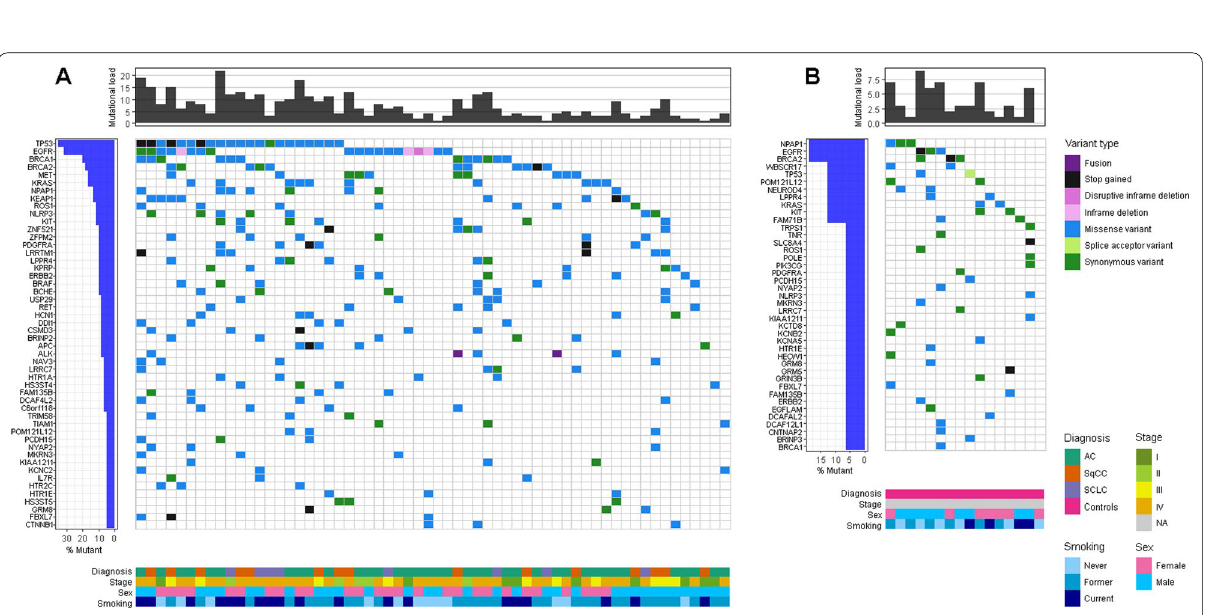
Fig. 3 Variant characteristics in plasma. A Variants in the lung cancer cohort. Top 50 most commonly mutated genes are shown. B Variants in the control group. All genes with detected variants are shown. Controls consisted of patients referred to the lung clinic with the suspicion of lung cancer but later diagnosed with different benign lung diseases. AC adenocarcinoma, SqCC squamous cell carcinoma, SCLC small cell lung